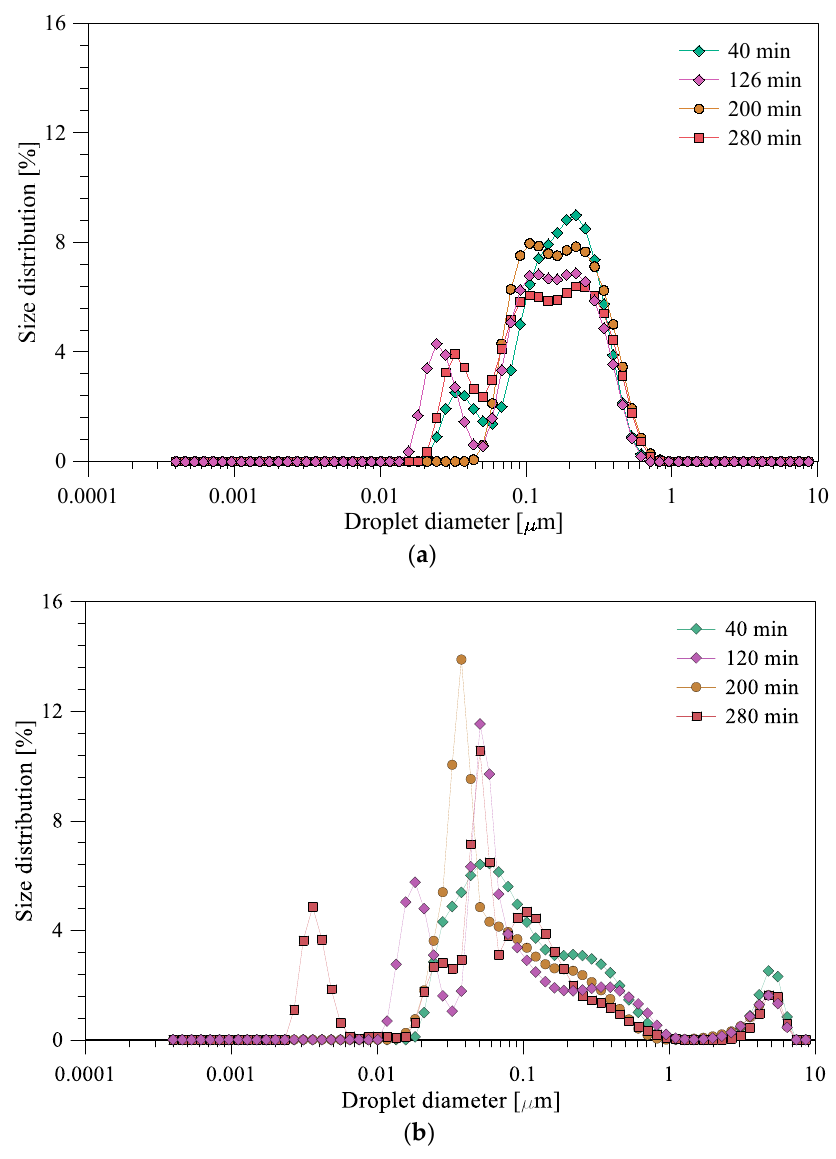
Figure 4. Droplet size distribution measured for applied pressures of ( a ) 0.25 and ( b ) 1